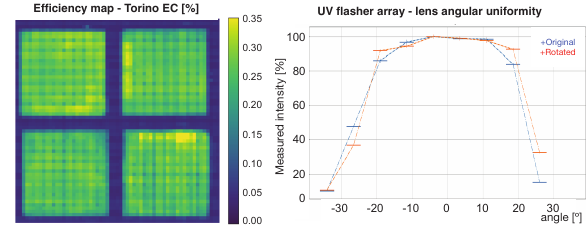
Figure 5: Left: PDE map of Torino EC. Right: Results of the flasher angular